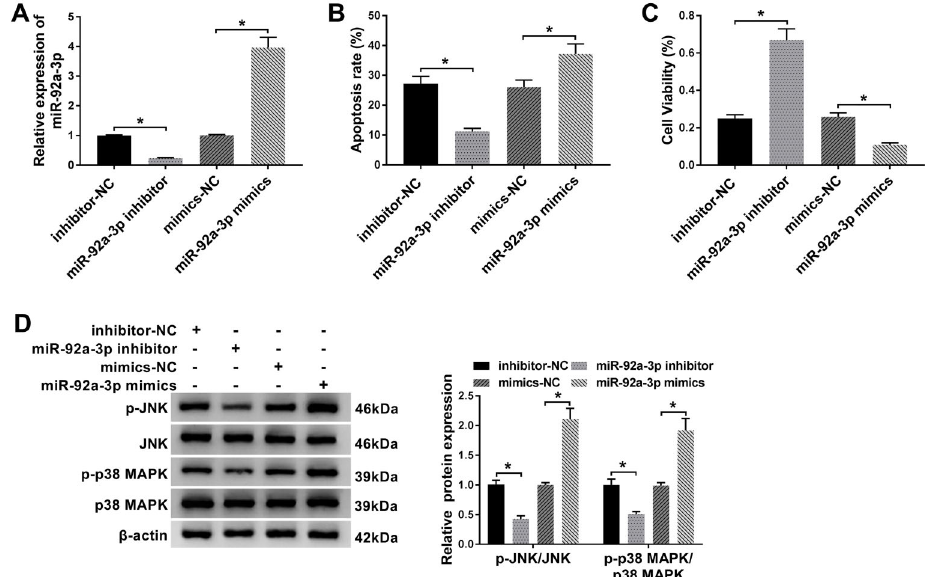
Figure 3. Functional roles of miR-92a-3p in oxidized low-density lipoprotein (ox-LDL)-treated human umbilical vein endothelial cells (HUVECs). HUVECs were treated with 50 m g/mL of ox-LDL for 48 h and transfected with inhibitor-negative control (NC), miR-92a-3p inhibitor, mimics-NC, or miR-92a-3p mimics. A , RT-qPCR assay was carried out to evaluate the expression level of miR-92a-3p in HUVECs. B , Apoptosis of HUVECs was determined by fl ow cytometry assay. C , MTT analysis was utilized to assess cell viability in HUVECs. D , The expression levels of p-JNK/JNK and p-p38 MAPK/p38 MAPK were measured by western blot assays. Data are reported as means ± SD with three replicates. *P o 0.05 (ANOVA).